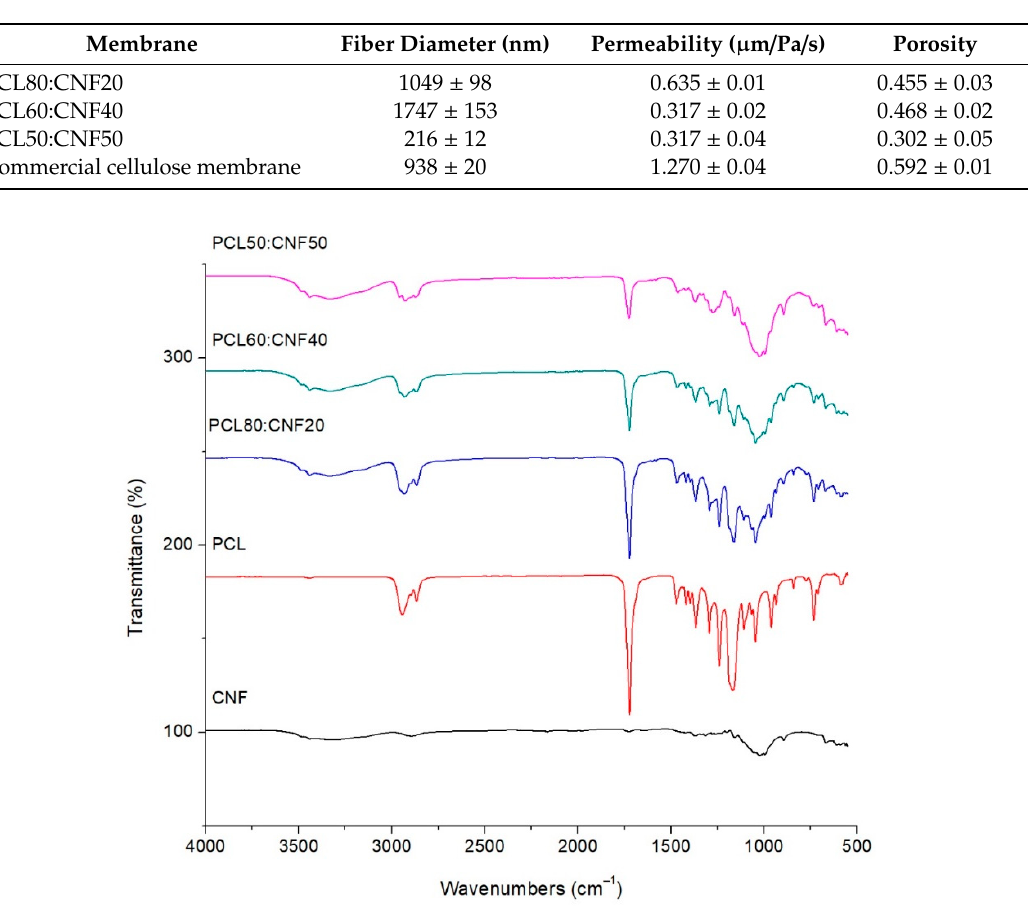
Table 1. Morphology of electro-spun nanofibers constituting the membranes. PCL = polycaprolactone and CNF = cellulose nanofiber.